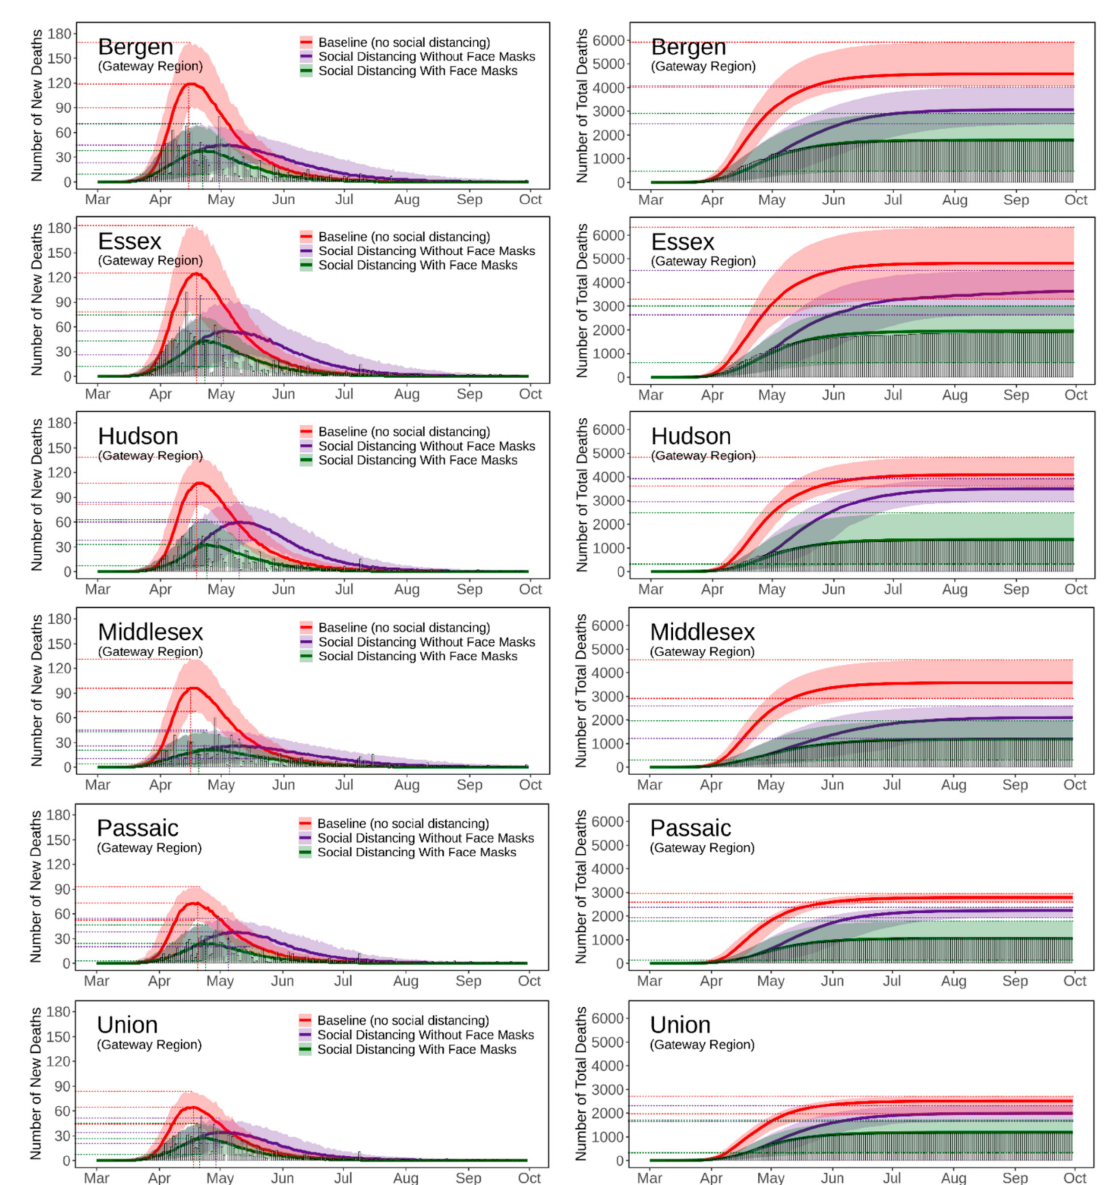
Figure 4. Predicted trajectories of new/total confirmed deaths from COVID-19 corresponding to three exposure scenarios for the counties in the Gateway Region of NJ, March to September 2020, compared with reported death data (vertical bars). The color-shaded areas depict the 95% Confidence Interval (CI) of the corresponding